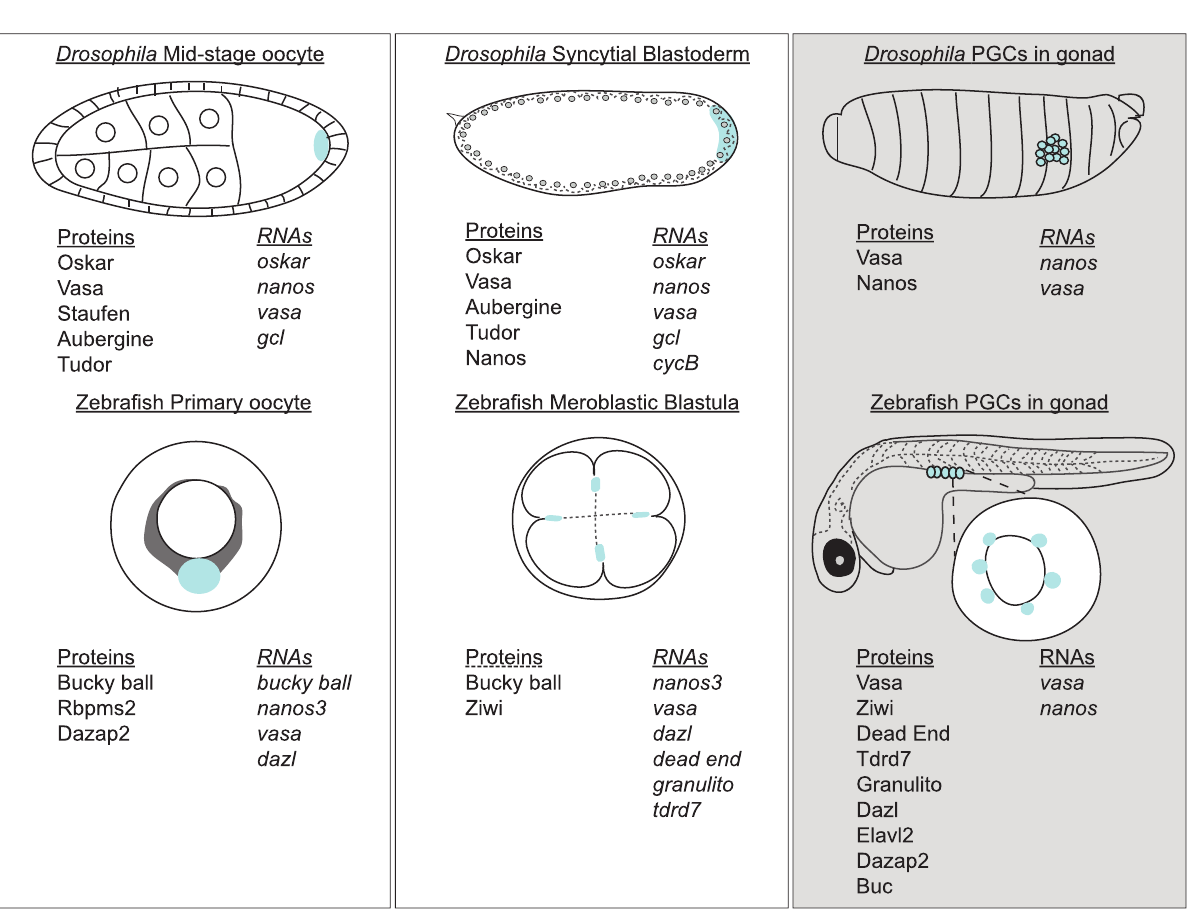
Figure 2. Comparison of maternal germ plasm and zygotic germ granule components between two organisms, Drosophila and zebrafish, that use maternal inheritance to specify their primordial germ cells (PGCs). The first column depicts the localization of germ plasm components (listed beneath the cartoon) at the posterior pole of mid-stage oocytes of Drosophila (top) and in the Balbiani body of early-stage oocytes of zebrafish. After fertilization, maternal germ plasm components (listed beneath the schematic) localize to specific membranes within the syncitial blastoderm of Drosophila and meroblastic cleavage (cells are incompletely separated and connected to the yolk) stage zebrafish embryos. The cells that receive these membranes develop as the PGCs. White rectangles depict maternal germ plasm components. The last column (grey rectangle) depicts PGCs of Drosophila and zebrafish after their migration to the gonad and indicates components of embryonic PGCs and germ granules. Dazap2, deleted in azoospermia-associated protein 2; Dazl, deleted in azoospermia-like; Elav, HuC; gcl , germ cell-less; Rbpms2 , ribonuclear-binding protein with multiple splice isoforms